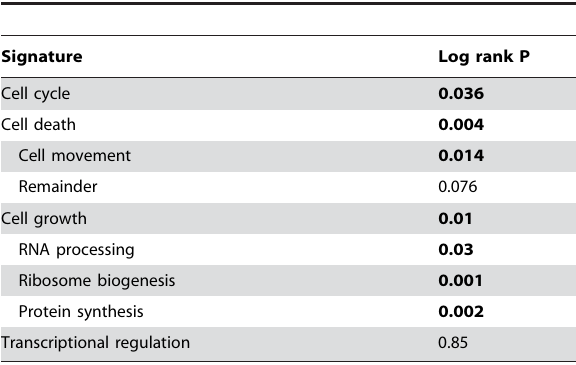
Table 2. Analysis of functional signatures in tamoxifen- treated